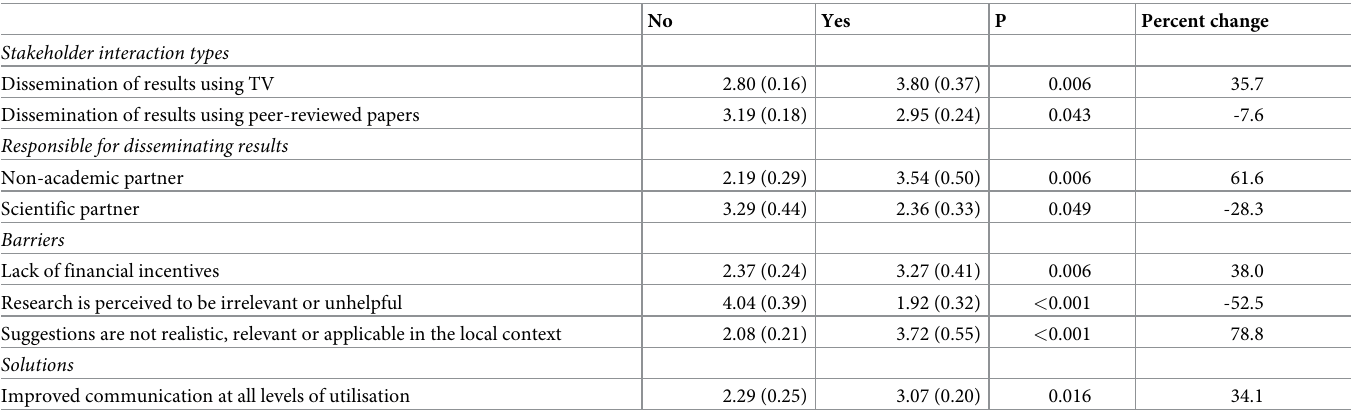
Table 4. Factor levels significantly affected with differences in RKU on the scale defined by